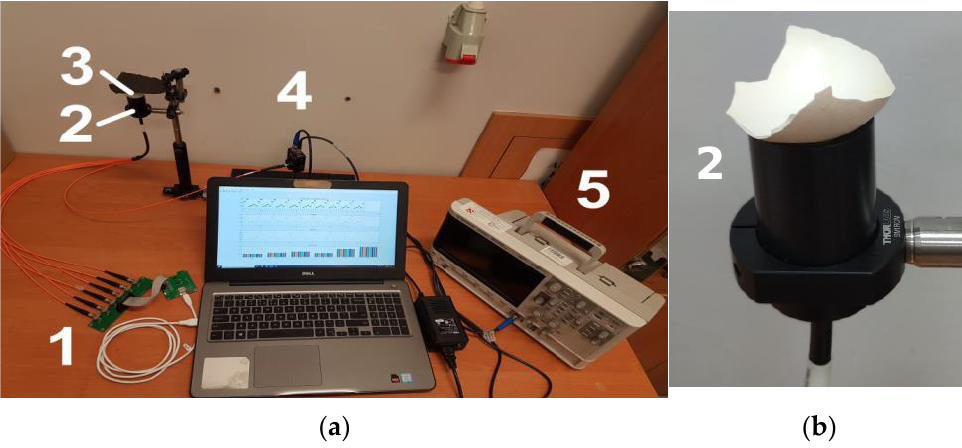
Figure 1. The images of: ( a ) the laboratory portable multispectral fibre-optic reflectometer setup: an electronic driving unit with a set of six LEDs integrated into an electronic board and a 1 × 7 fun-out fibre-optic bundle (1), measuring head (2), tested object with a shade (3), a photodetector unit (4) and an oscilloscope (5); ( b ) measuring head with the tested piece of the eggshell.